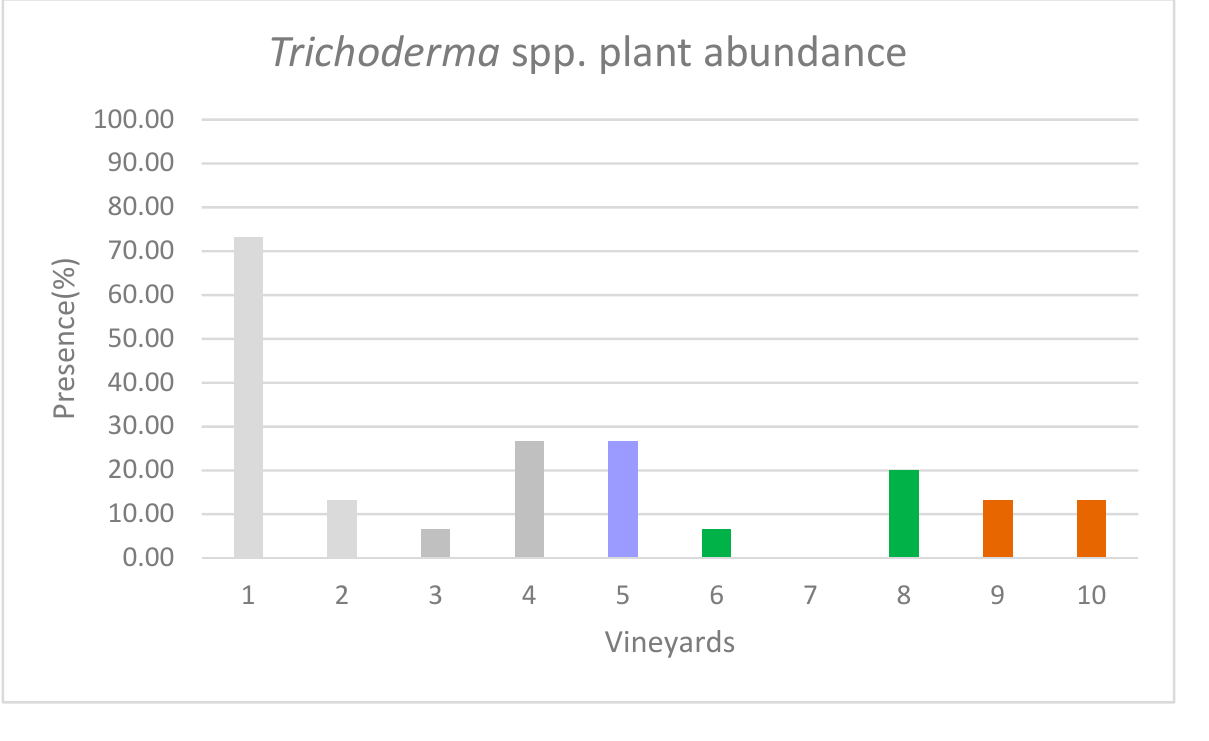
Figure 2. Trichoderma plant abundance. The code of each soil is detailed in Table 1. A selection was performed to avoid duplicity of same isolates in same plots due to their morphological and cultural characteristics in case that they belonged to the same plant, and finally they were confirmed using genetic identification by PCR amplification and sequencing. As result, 25 Trichoderma isolates from bark vine (rhytidome) were finally selected in Table 3. T. gamsii was identified at the highest frequency (48%; 12/25).